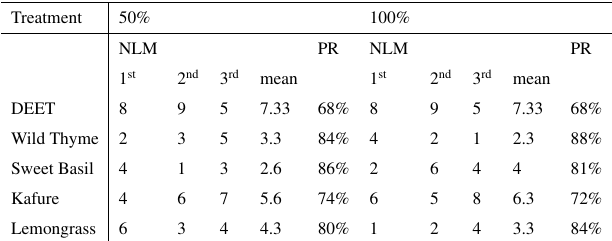
Table 7. Percent repellency (PR) according to the number of landed mosquitoes (NLM) of 50% and 100% of evaluated plant leaves hexane and ethanol extracts mixture against Anopheles mosquito.